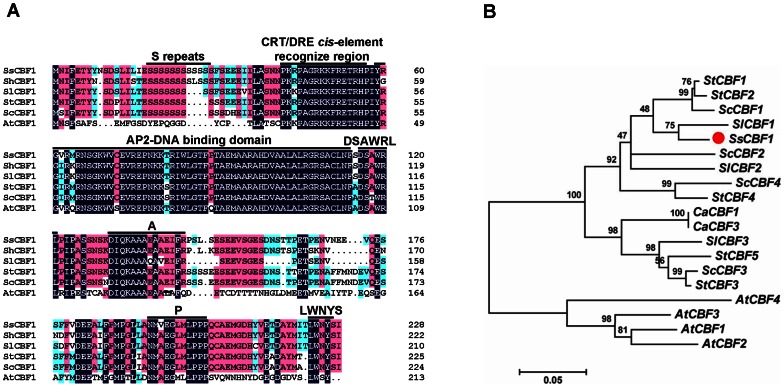
Sequence analysis of SsCBF1.(A) Amino acid sequence alignment between SsCBF1 and other known CBF1s. The alignment was performed using ClustalX 2.0 and DNAMAN software. Black background indicated conserved residues among all the proteins selected. The AP2 DNA-binding domain and other signature motifs were indicated by solid lines. (B) Phylogenetic relationships between SsCBF1 and other CBFs from various species. The phylogenetic tree was generated by the neighbor-joining method using MEGA 5.0. Organisms were abbreviated as follows: St, Solanum tuberosum; Sc, Solanum commersonii; Sl, Solanum lycopersicum; Ss, Solanum lycopersicoides; Ca, Capsicum annuum; At, Arabidopsis thaliana. GenBank accession numbers of the CBFs are listed as follows: AtCBF1 (AEE85066), AtCBF2 (AEE85064), AtCBF3 (AEE85065), AtCBF4 (ABV27186), SsCBF1 (ACY79412), SlCBF1 (AAS77820), SlCBF2 (AAS77821), SlCBF3 (AAS77819), ScCBF1 (ACB45093), ScCBF2 (ACB45094), ScCBF3 (ACB45092), ScCBF4 (ACB45084), StCBF1 (ABI74671), StCBF2 (ABI94367), StCBF3 (ACB45095), StCBF4 (ACB45083), StCBF5 (ACB45082), CaCBF1 (AAZ22480), CaCBF3 (ADM73296).